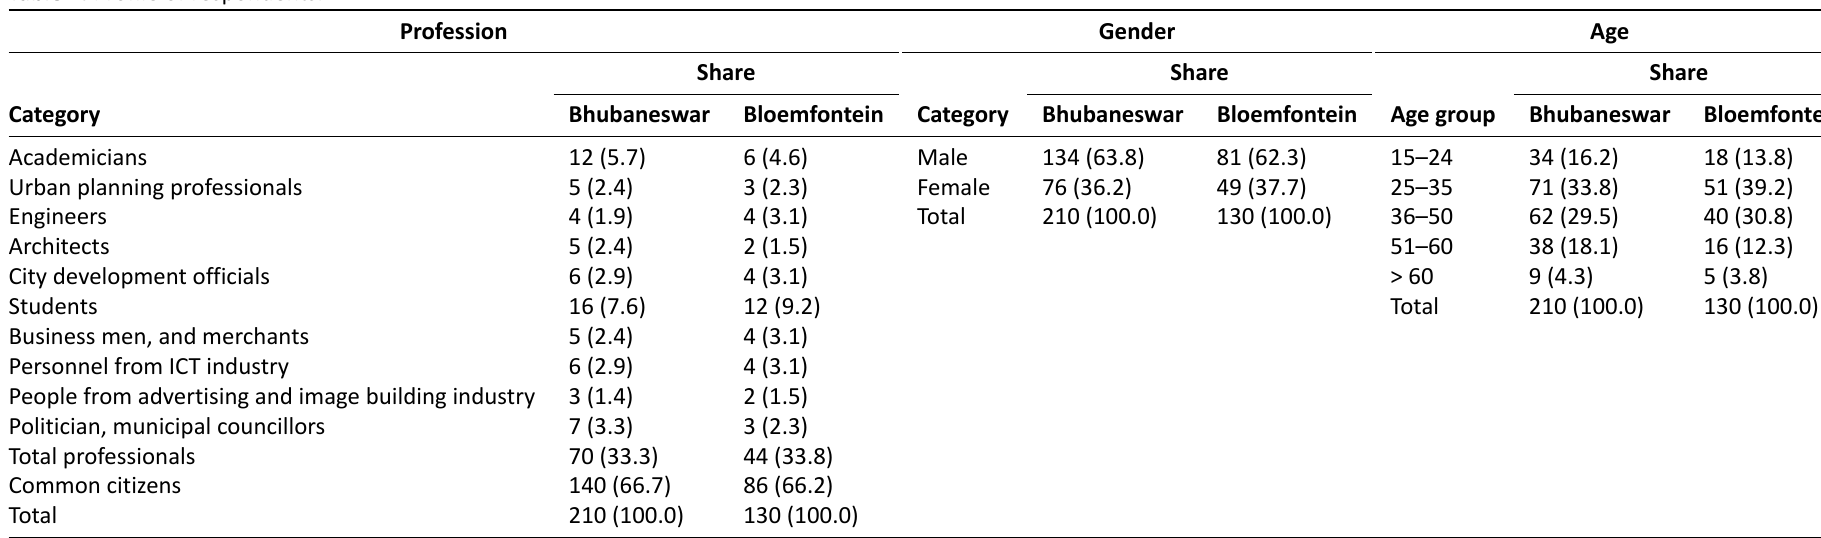
Table 1. Profile of